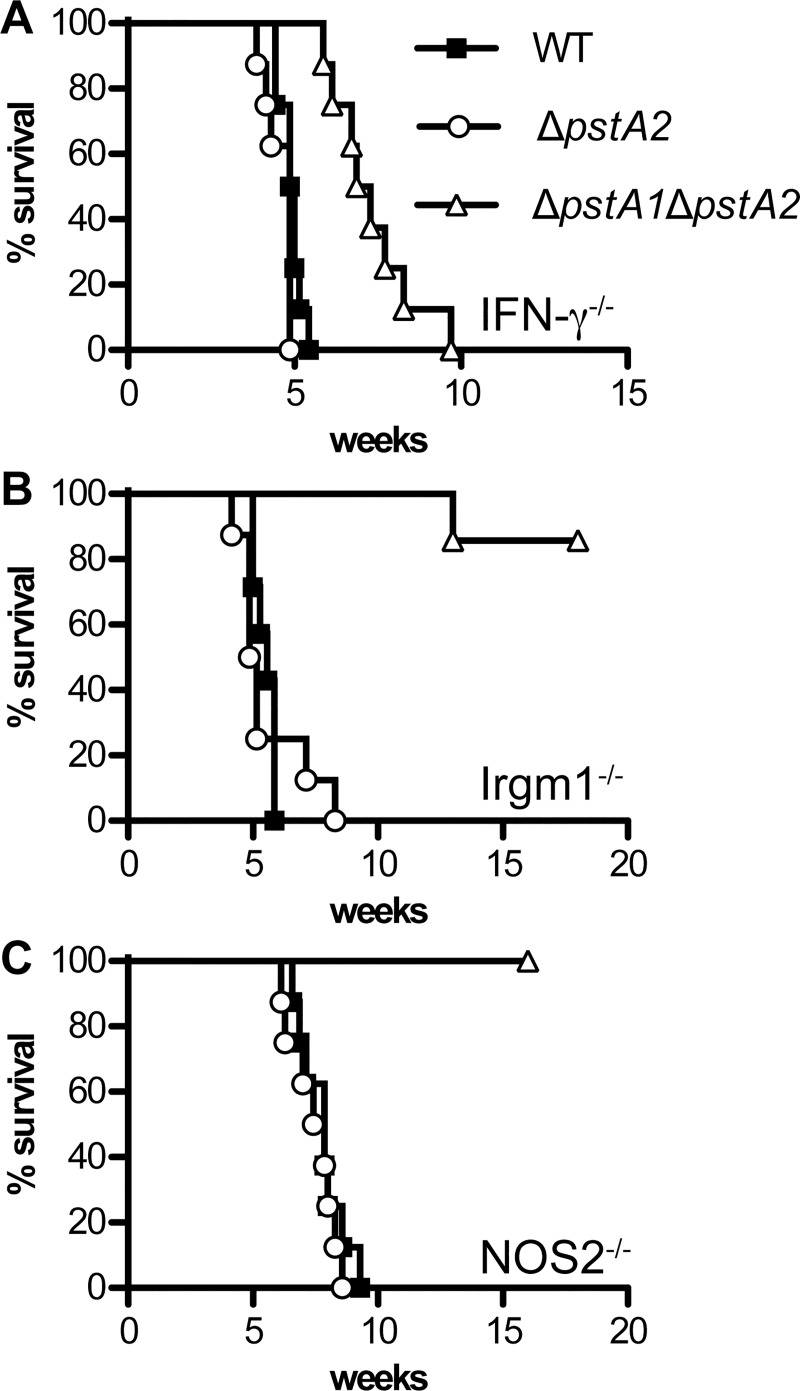
Virulence of M. tuberculosis ΔpstA2 and ΔpstA1ΔpstA2 mutants in immune-deficient mice.Groups of immune-deficient mice (n = 8), all on the C57BL/6 background, were aerosol-infected with ~100 CFU of wild-type M. tuberculosis (WT, squares), ΔpstA2 (circles), or ΔpstA1ΔpstA2 (triangles) and monitored for signs of illness. Moribund mice were euthanized and scored as dead. (A) IFN-γ-/-, (B) Irgm1-/-, (C) NOS2-/-.